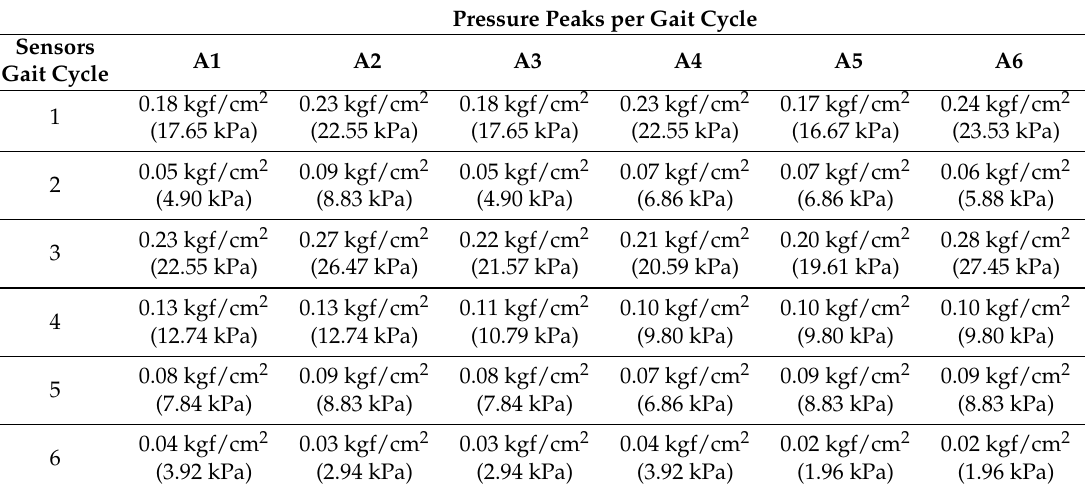
Figure 20. Higher pressures generated during second minute of the gait for SD2. Table 3. Peak pressures recorded by the sensors in each cycle of the gait for